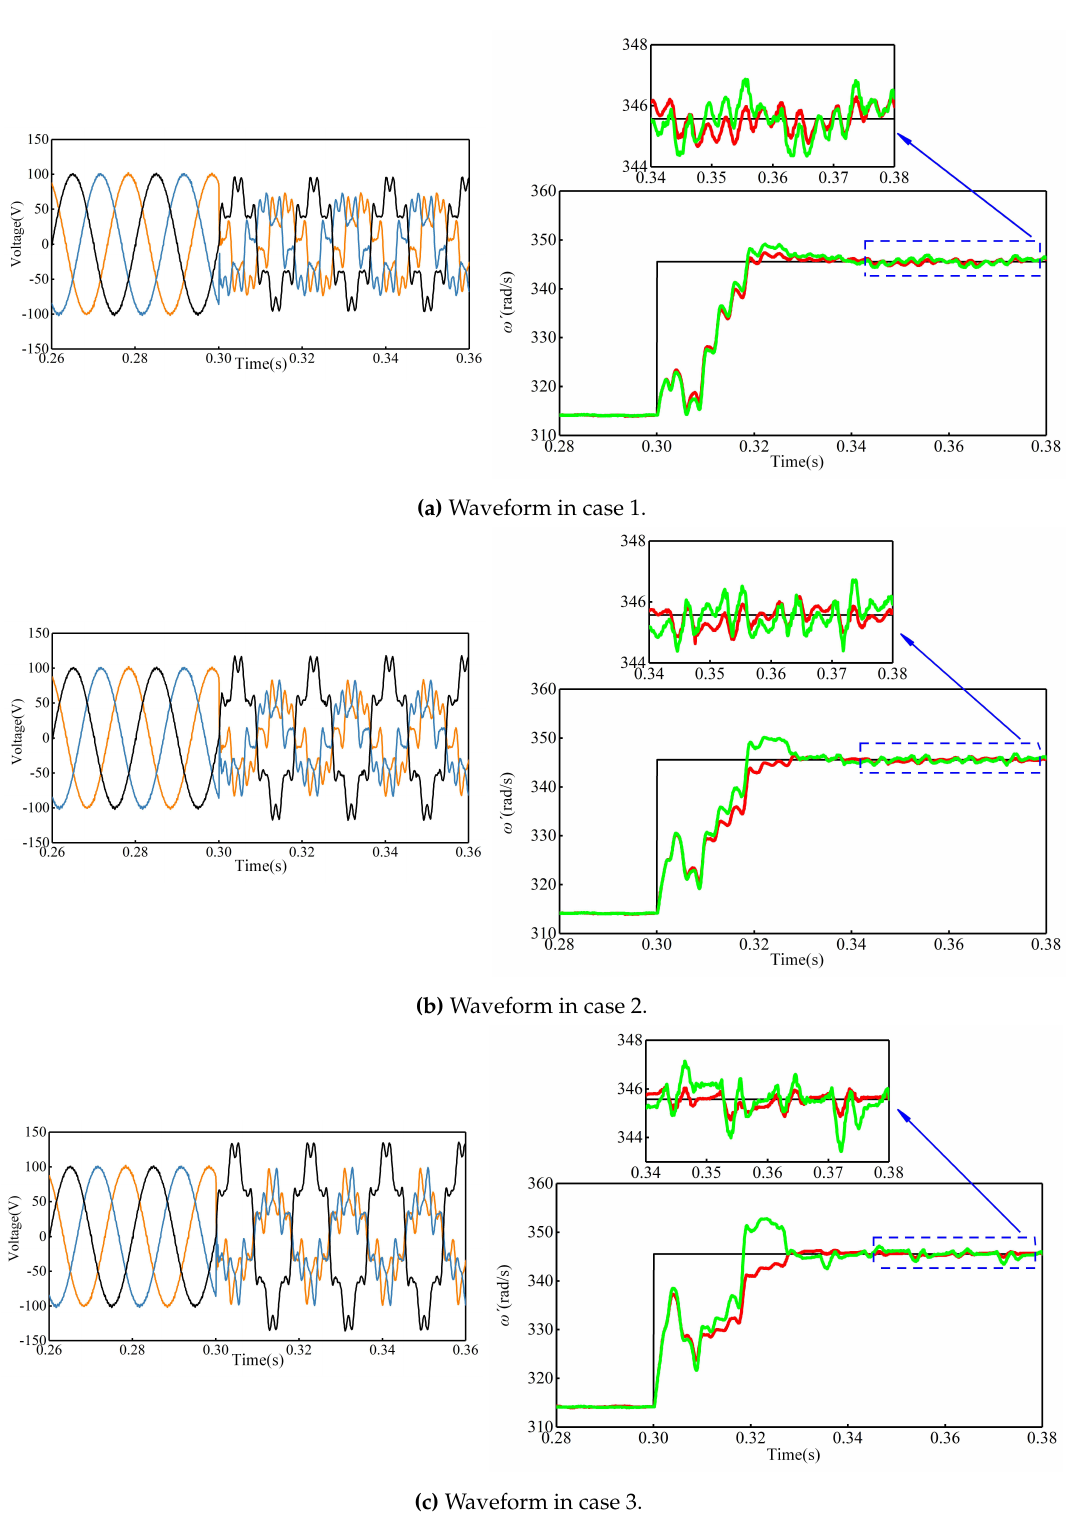
Figure 10. Waveforms of the grid voltage and frequency estimated by the MDSOGI-FLL (green line) and the MDSOGI-IFLL (red